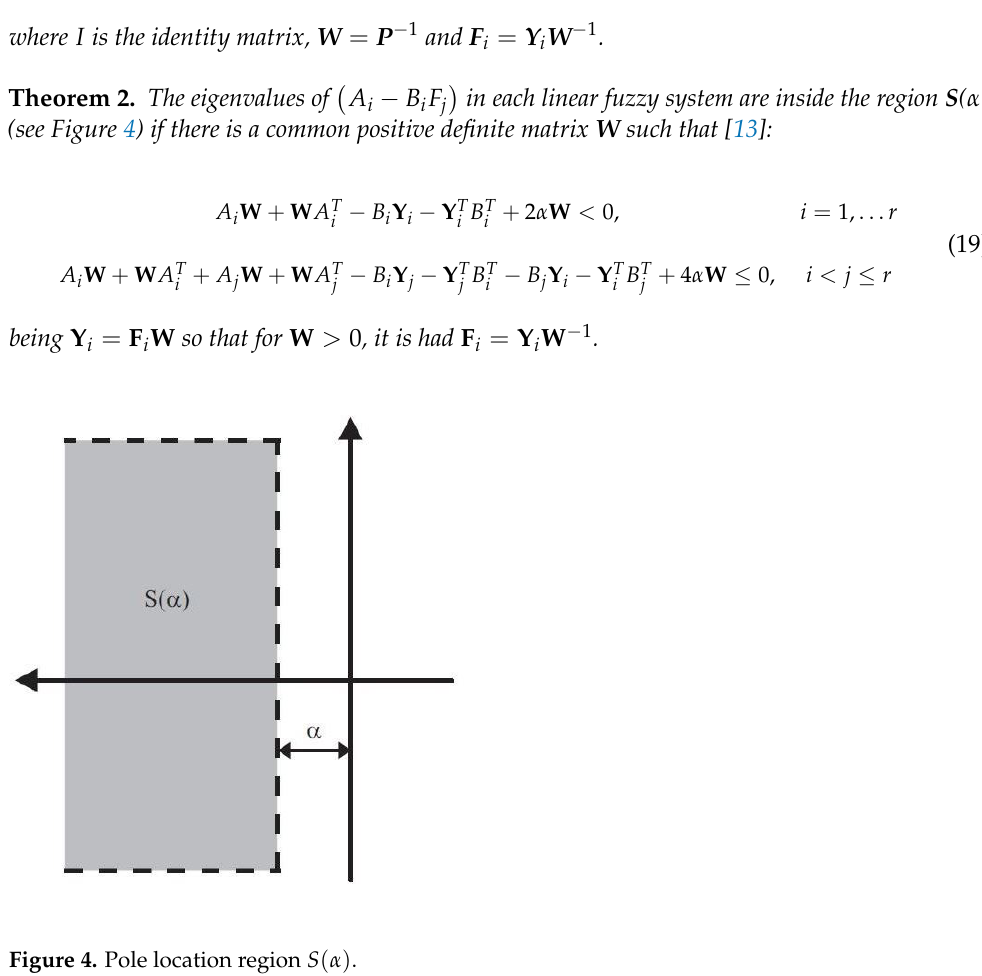
Figure 4. Pole location region S ( α )